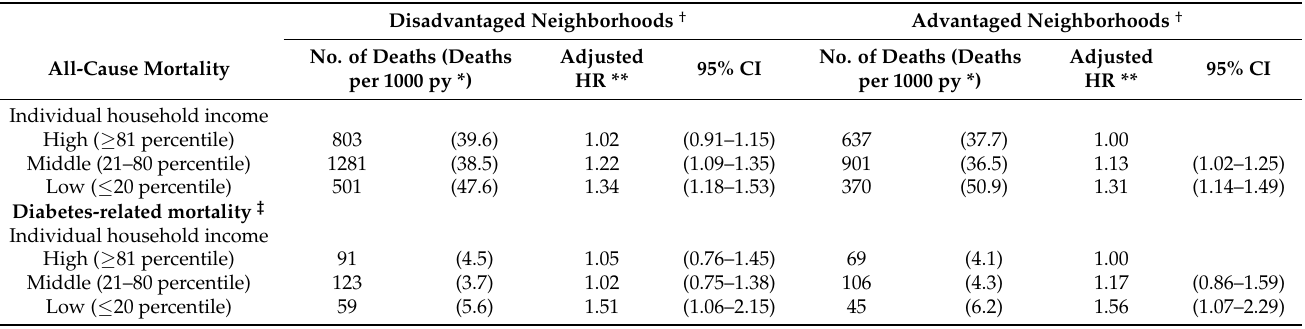
Table 3. Mortality HRs adjusted for individual household income in disadvantaged and afflu- ent